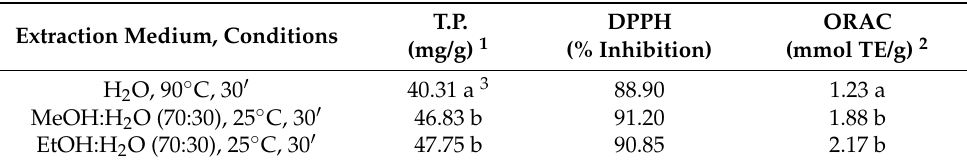
Table 4. Antioxidant capacity of olive leaf extracts obtained by different methods using water at 90 ◦ C, 70% methanol, and 70% ethanol.